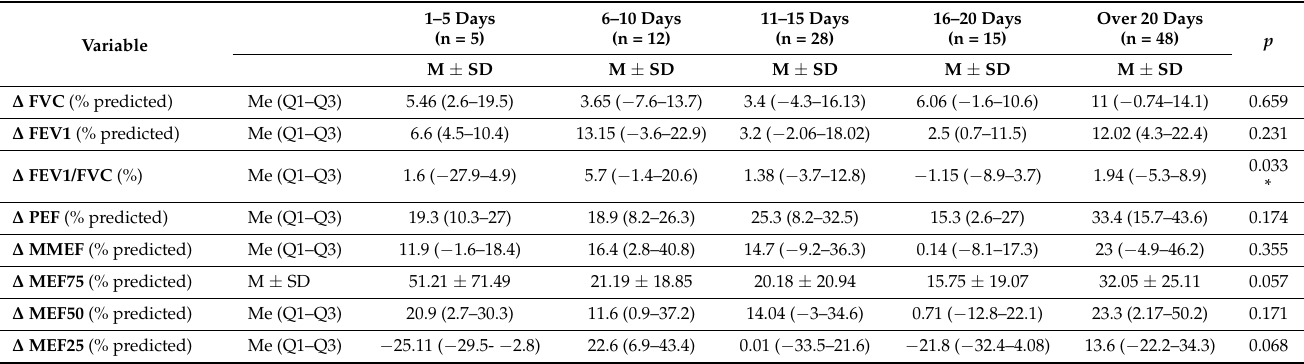
Table 9. Relationships between the difference in spirometric results before and after rehabilitation and the length of hospitalization in the course of COVID-19.